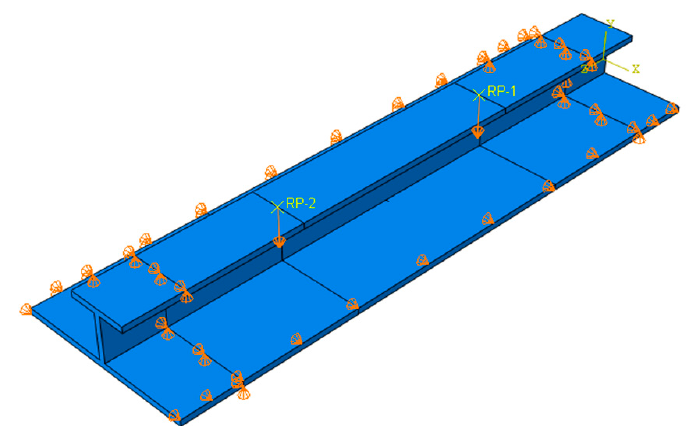
Figure 13. Geometry and boundary conditions of bending model.